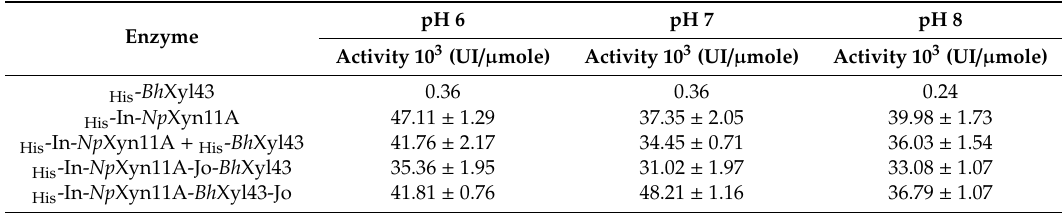
Table 3. Comparison of the activity of the di ff erent enzyme at various pH. Activity is expressed as the amount of µ moles of product formed per minute and per µ moles of enzymes. Hydrolysis